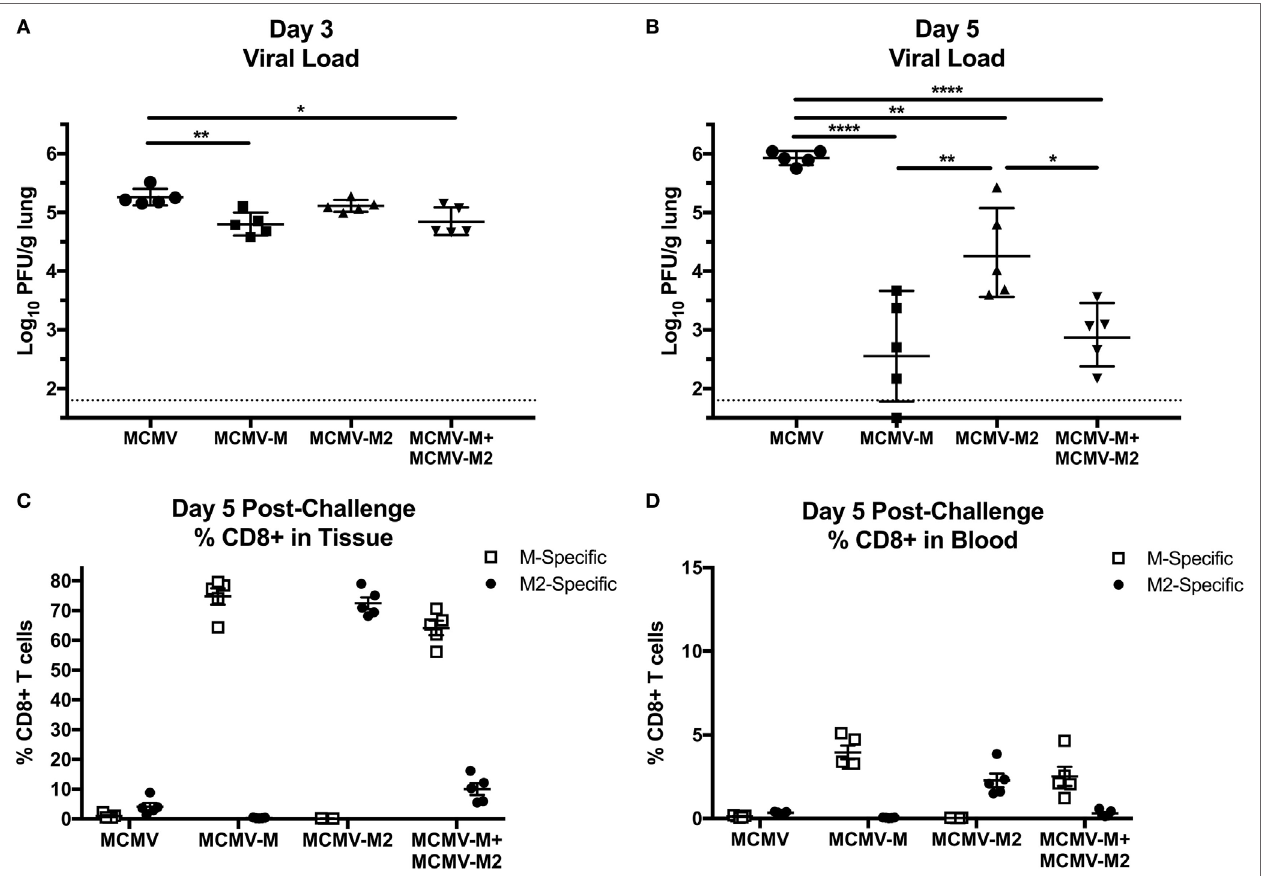
FigUre 6 | Murine cytomegalovirus (MCMV)-elicited tissue-resident memory T cells expedite viral clearance after infection with respiratory syncytial virus (RSV). (a–D) Mice were vaccinated with MCMV vector, MCMV-M or MCMV-M2 alone, or a combination of MCMV-M and MCMV-M2 via the intranasal route and challenged with RSV at week 16. Viral titers in the lungs were measured by plaque assay on days 3 (a) and 5 (B) . **** P < 0.0001, *** P < 0.001, ** P < 0.01, * P < 0.05 by one-way ANOVA. (c,D) Intravascular staining was used in conjunction with D b /M 187–195 and K d /M2 82–90 tetramers to quantify M-specific and M2-specific CD8 + T cells in the lungs (c) and the blood (D) . **** P < 0.0001, ** P < 0.01, * P < 0.05 by two-way ANOVA. Data shown from one experiment and representative of two independent